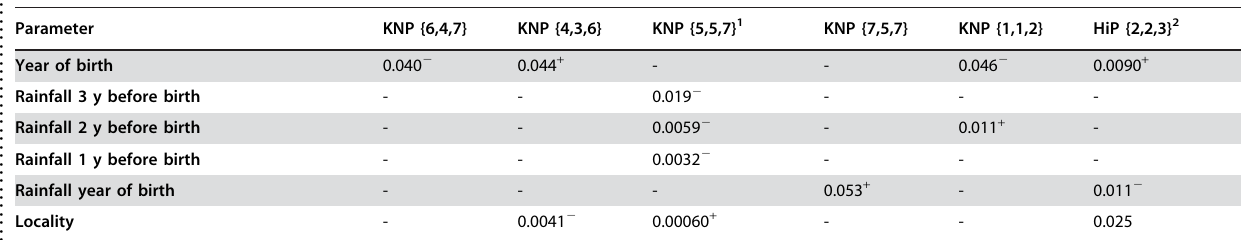
Table 1. P values of the parameters in the logistic regression model for haplogroup frequencies. .. ... .... ... ... .... ... ... .... ... ... .... ... ... .... ... ... .... ... ... .... ... ... .... ... ... .... ... ... .... ... ... .... ... ... .... ... ... .... ... ... .... ... ... .